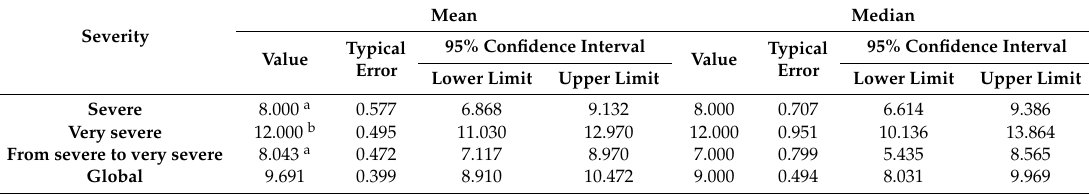
Table 4. Log rank-Mantel–Cox statistical analysis comparing the remission time of dogs with severe and very severe skin lesions. This test allows the creation of a third set of results, i.e., the passage from very severe to severe, as an estimate of clinical progress. Mean Median 95% Confidence Interval 95% Confidence Typical Typical Value Value Error Error